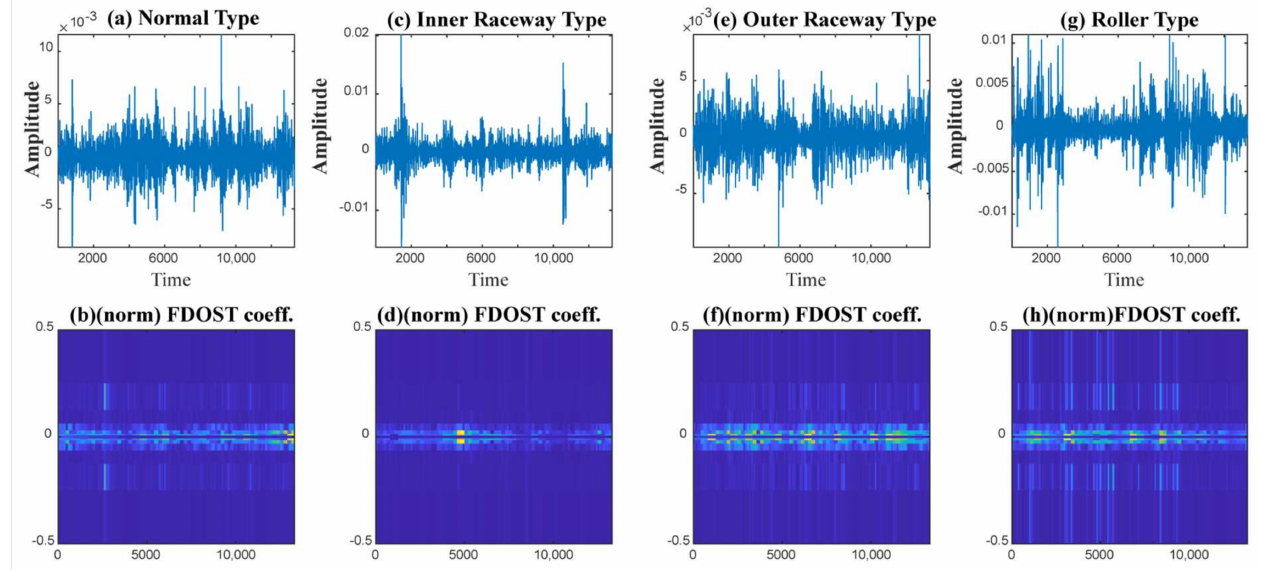
Figure 17. The visualization of dataset 2 in terms of raw time domain signals and the respective 2D FDOST coefficient matrix—( a , b ): time domain, and 2D FDOST coefficient of NT, ( c , d ): time domain, and 2D FDOST coefficient of IRT, ( e , f ): time domain, and 2D FDOST coefficient of ORT, and ( g , h ): time domain, and 2D FDOST coefficient of RT.